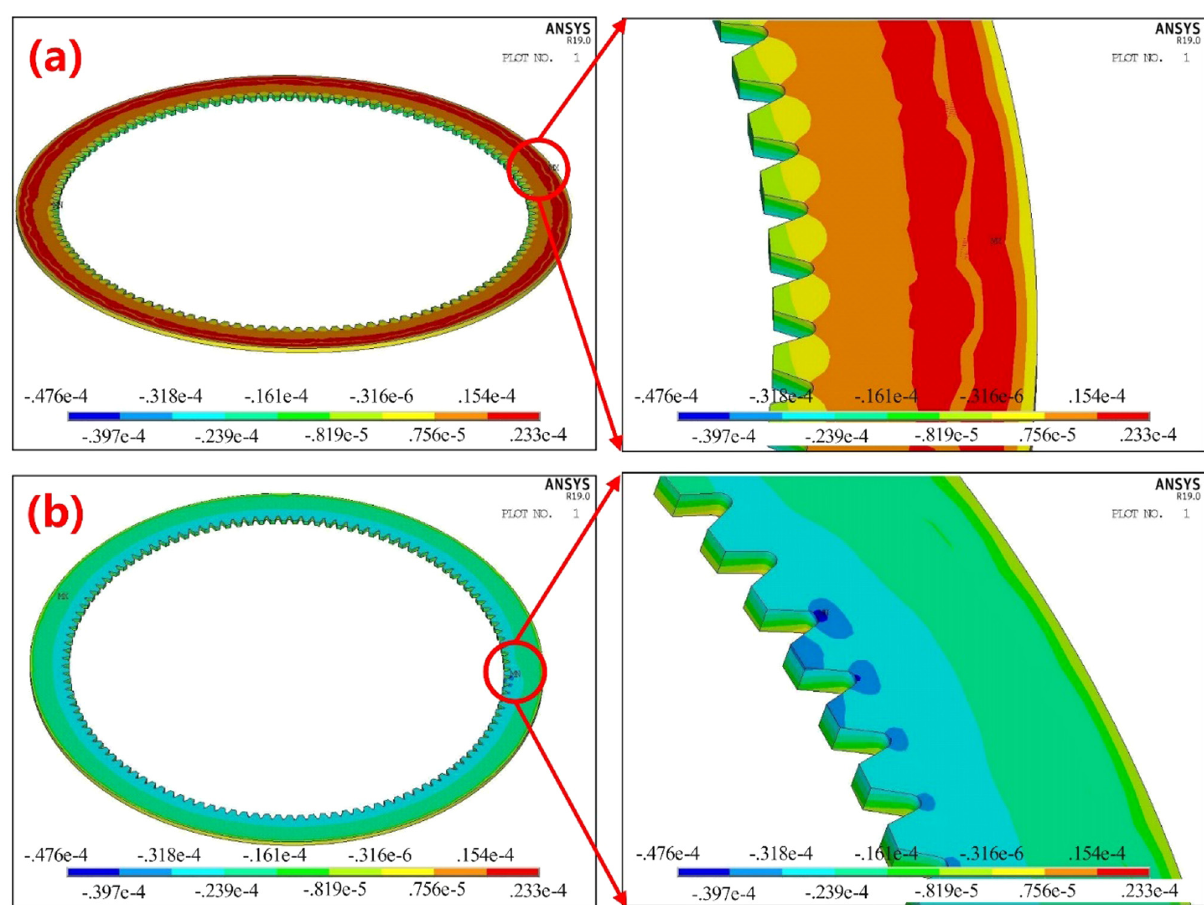
Figure 5: The nephogram results of machining deformation: ( a ) the front face and ( b ) the bottom